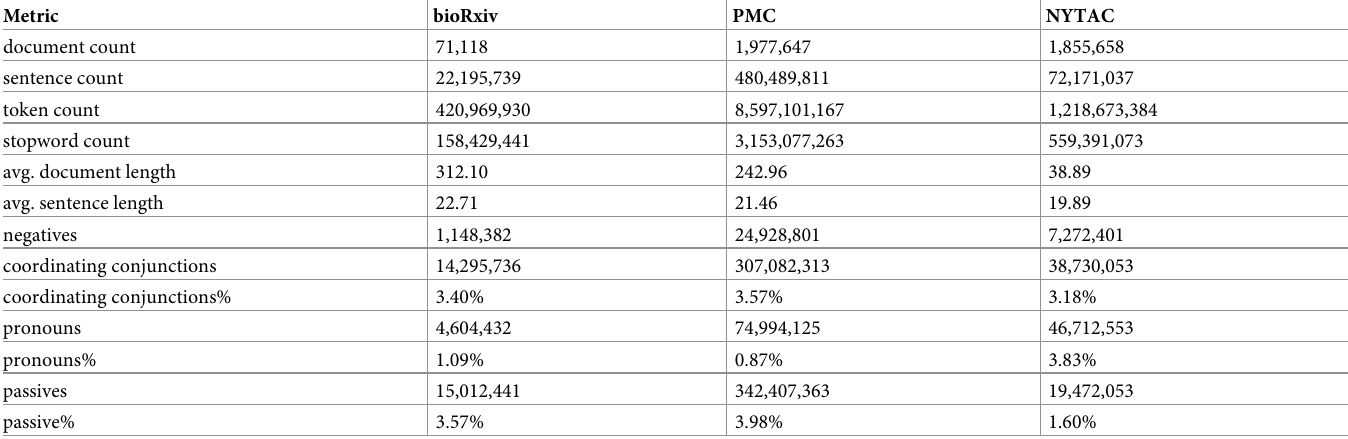
Table 1. Summary statistics for the bioRxiv, PMC, and NYTAC